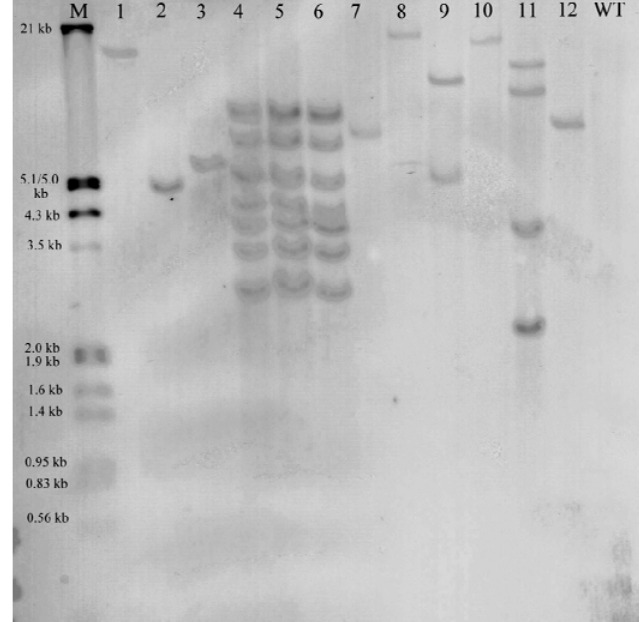
Figure 6. Southern blot analysis of T plants carrying the hpt transgene. Genomic DNA 0 from transgenic plants expressing the GUS transgene was restricted with Eco RV and hybridized to a DIG-labeled hpt probe. DIG-labeled DNA molecular weight marker III is shown in lane M. In lanes 4-6, are samples from individual plants regenerated from the same hygromycin resistant callus showing identical banding patterns and indicating the plants are likely clones carrying multiple identical T-DNA insertions. In lanes 1-3, 7-12 individual plants regenerated from independent hygromycin resistant calli, with several carrying simple T-DNA insertions. In lane WT, DNA from wild-type untransformed O. sativa cv Nipponbare as a negative control shows no